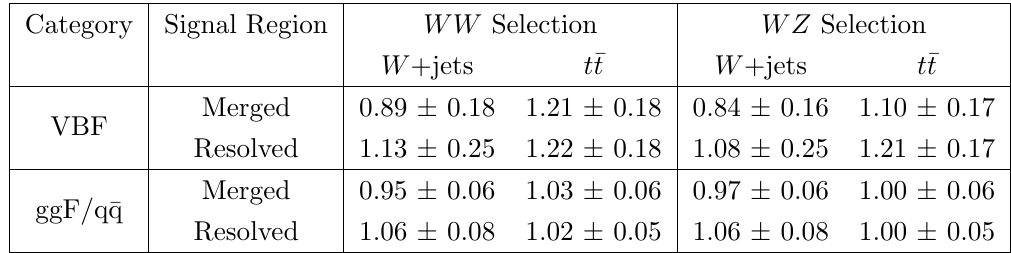
Table 3 . Normalization factors, de(cid:12)ned as the ratio of the number of (cid:12)tted events to the number of predicted events from simulation, of the main background sources, namely W +jets and t (cid:22) t , in the VBF and ggF = q(cid:22)q categories. The quoted uncertainties incorporate statistical and systematic